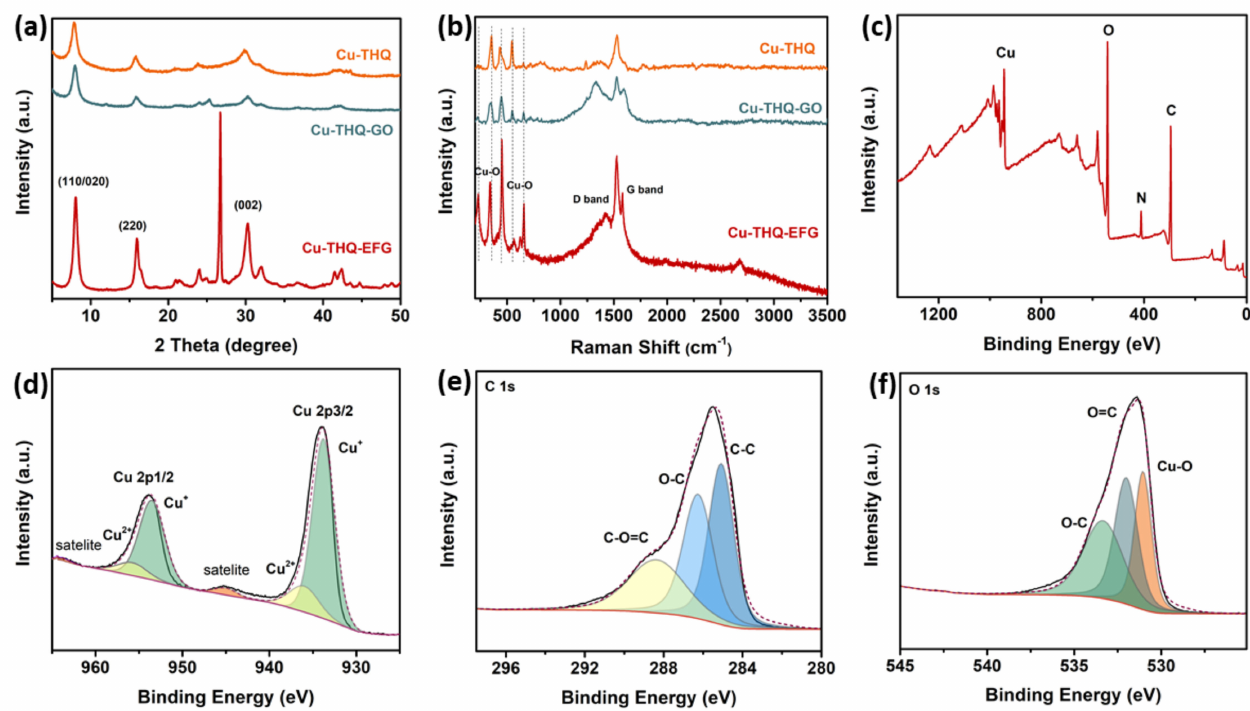
Figure 2. ( a ) XRD, ( b ) Raman spectra of pristine MOF (yellow curve), MOF/GO composite (green curve) and MOF/EFG composite (red curve); High resolution XPS spectra of ( c ) survey, ( d ) Cu 2p, ( e ) C 1s, ( f ) O 1s in the